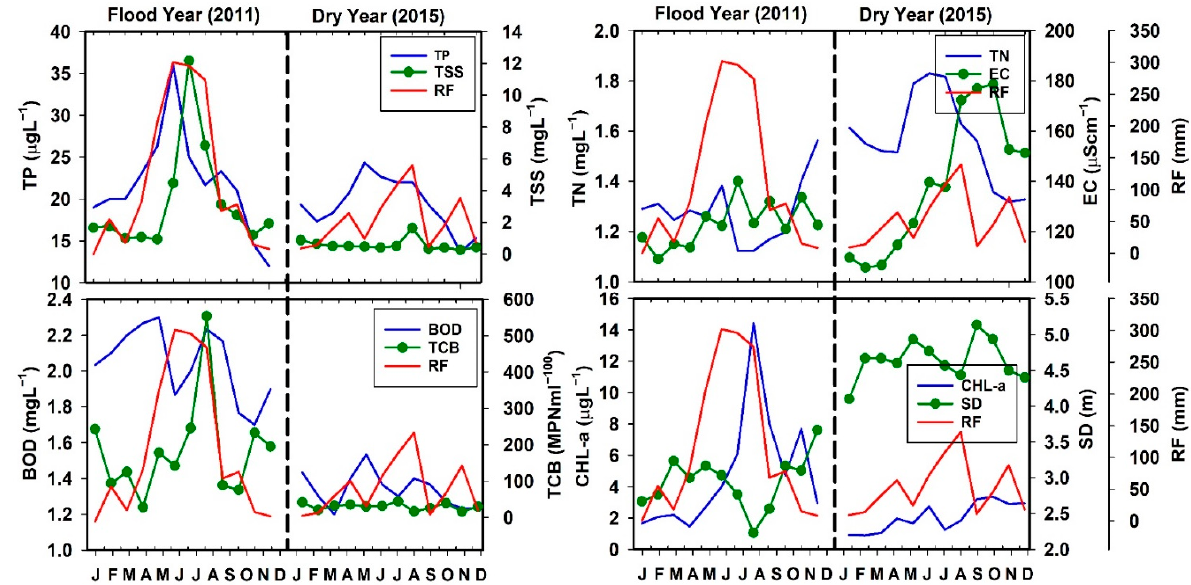
Figure 3. Monthly variations of TP, TSS, TN, EC, BOD, TCB, Chl-a, and SD in flood and dry years. (TP: total phosphorus, TSS: total suspended solids; TN: total nitrogen; EC: electrical conductivity; BOD: biological oxygen demand; TCB: total coliform bacteria; Chl-a: chlorophyll-a; SD: Secchi depth, and RF: rainfall).